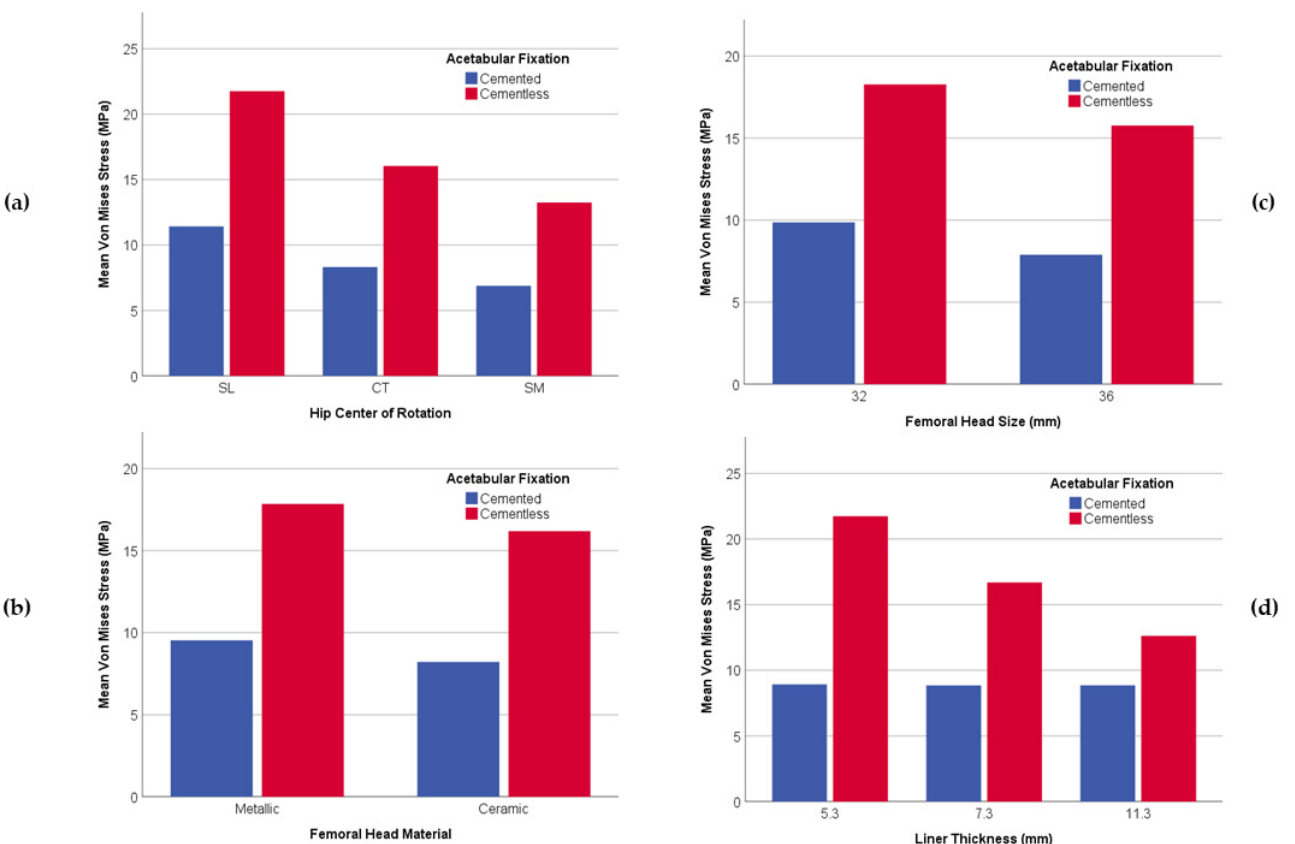
Figure 7. Bar graph with the relationship between variables and VM Stress (MPa); ( a ) VM Stress and Hip Center of Rotation; ( b ) VM Stress and Femoral Head Material; ( c ) VM Stress and Femoral Head Size; ( d ) VM Stress and Liner Thickness.